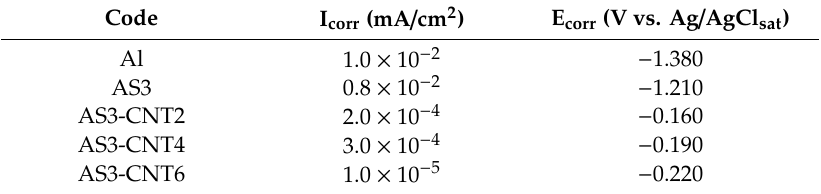
Table 2. Comparison of corrosion current and open circuit potentials for all